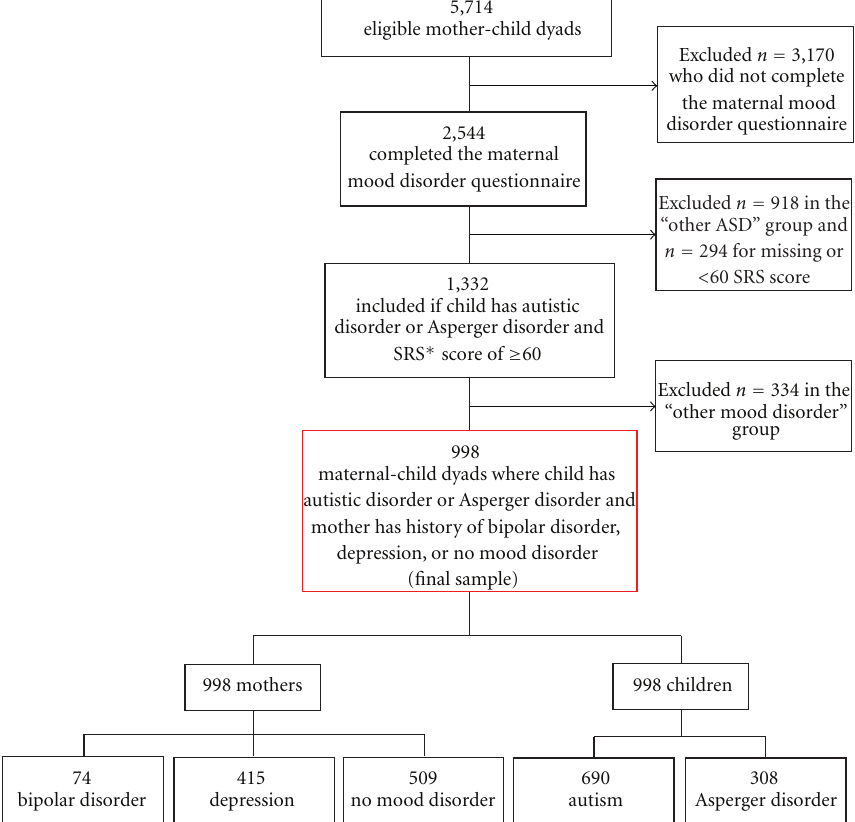
Figure 1: Participant eligibility diagram among children with autism spectrum disorder (ASD) and their biological